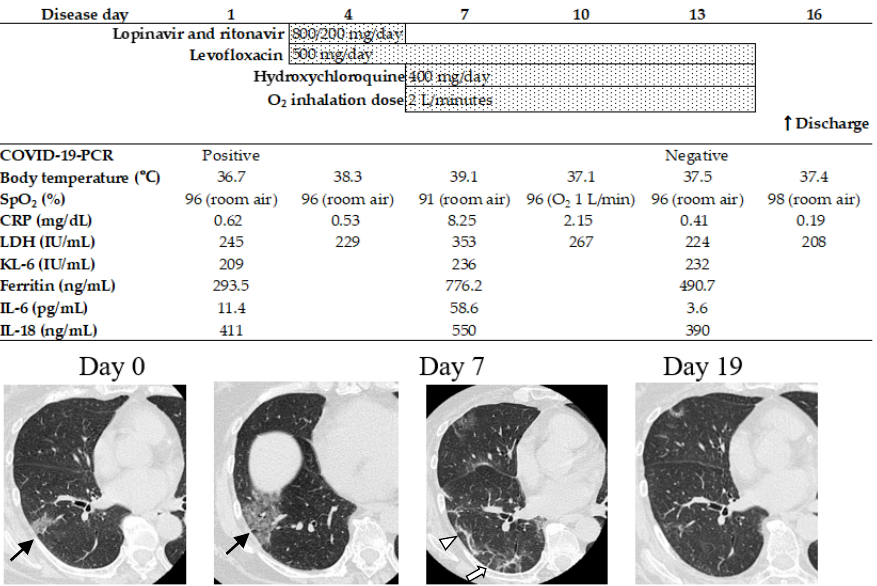
Figure 1. Clinical course of a representative case. O 2 , oxygen; COVID-19, coronavirus disease 2019; PCR, polymerase chain reaction; SpO 2 , oxygen saturation; CRP, C-reactive protein; LDH, lactate dehydrogenase; KL-6, Krebs von den Lungen-6, ground-glass opacitie; black arrow, interlobular septal thickening; white arrow, perilobular opacities and curvilinear line; arrow